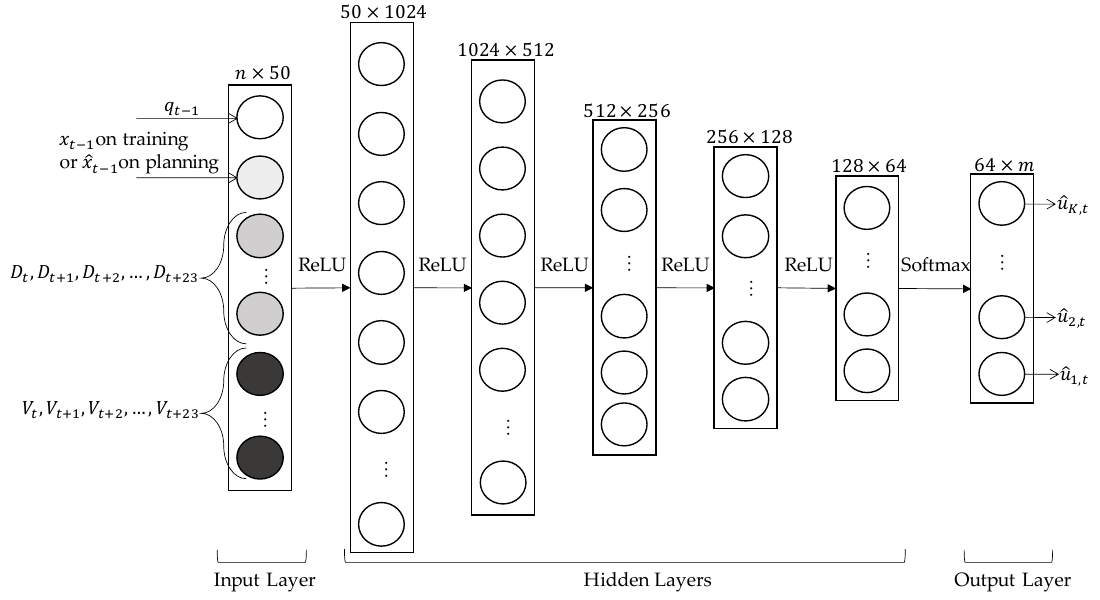
Figure 3. The network structure of the proposed deep learning model.